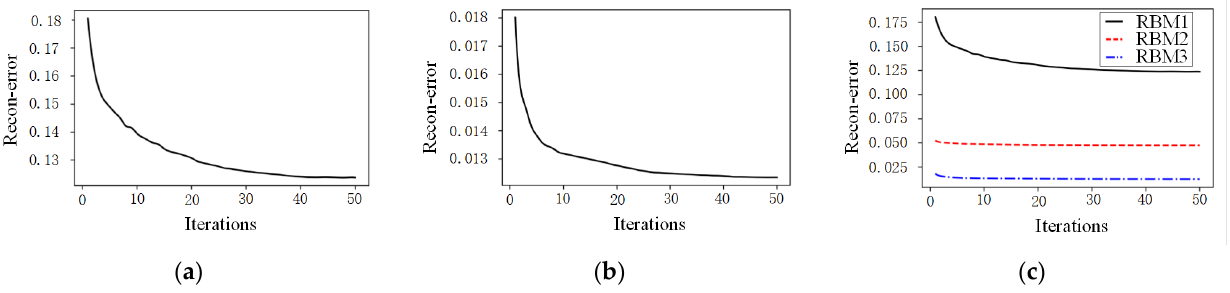
Figure 6. Recon-error of different RBM. ( a ) Recon-error of the bottom RBM. ( b ) Recon-error of the top RBM. ( c ) Recon- errors of three-layer RBMs.